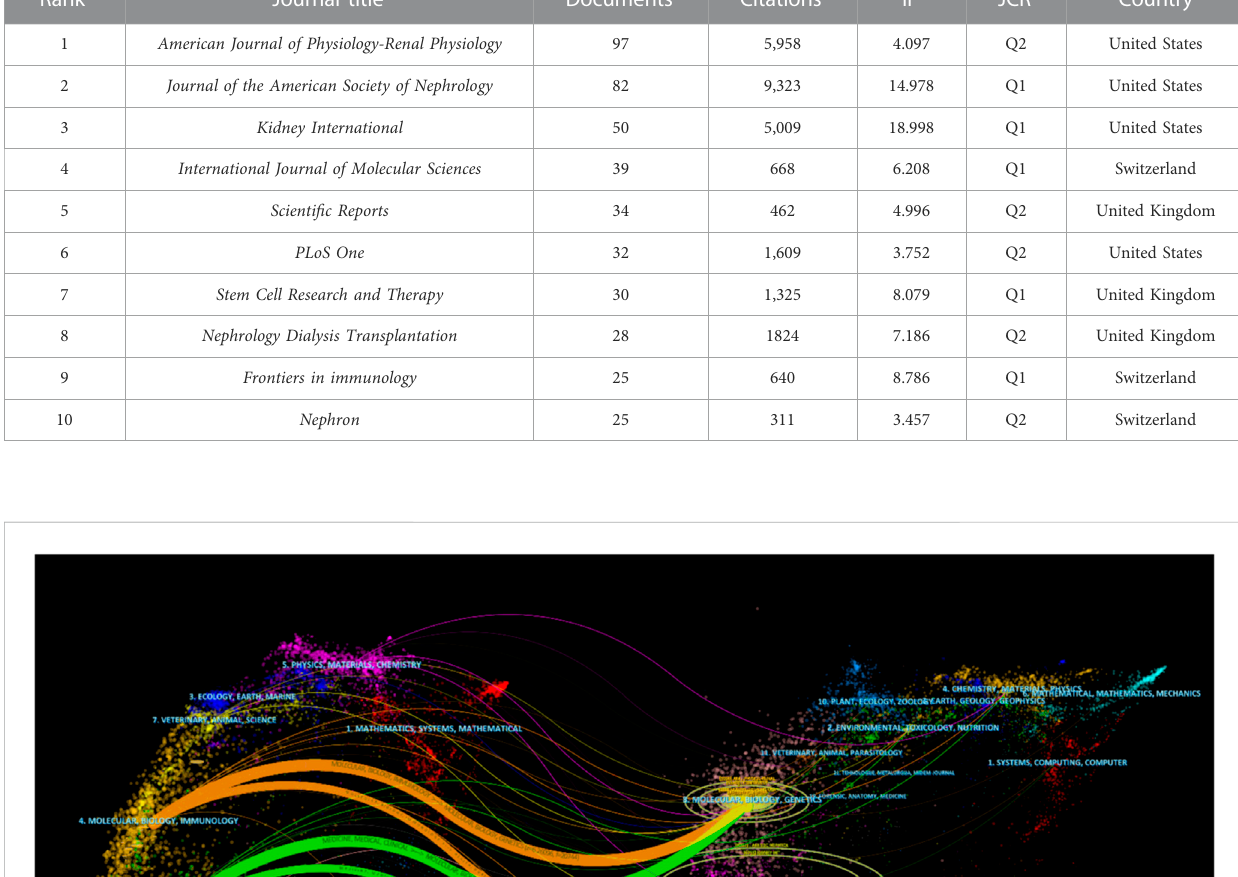
TABLE 4 Top 10 journals associated to the research on kidney repair in AKI. Rank